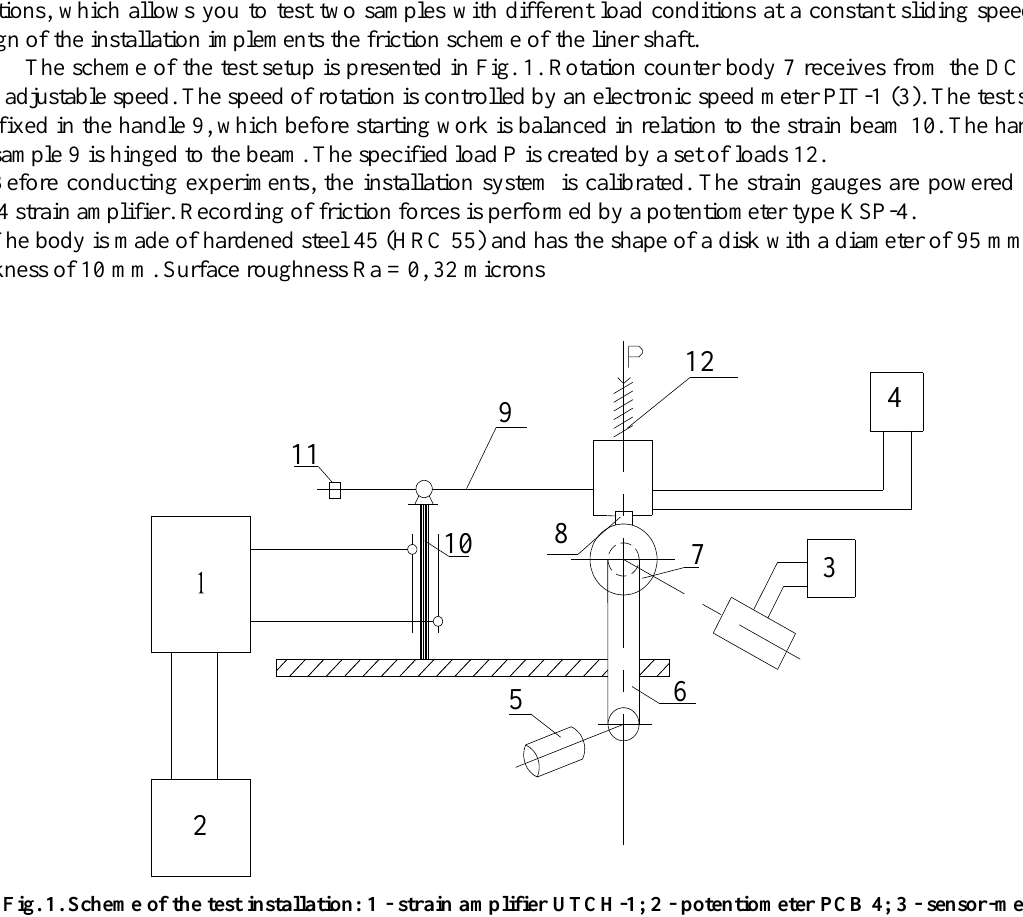
Fig. 1. Scheme of the test installation: 1 - strain amplifier UTCH-1; 2 - potentiometer PCB 4; 3 - sensor-meter of sliding speed; 4 - thermocouple temperature sensor potentiometer EPD-12; 5 - electric motor; 6 - V-belt transmission; 7 - working disk (counter body); 8 - experimental sample; 9 - sample holder; 10 - strain beam; 11 - load - balancer; 12 - loads to create the desired pressure